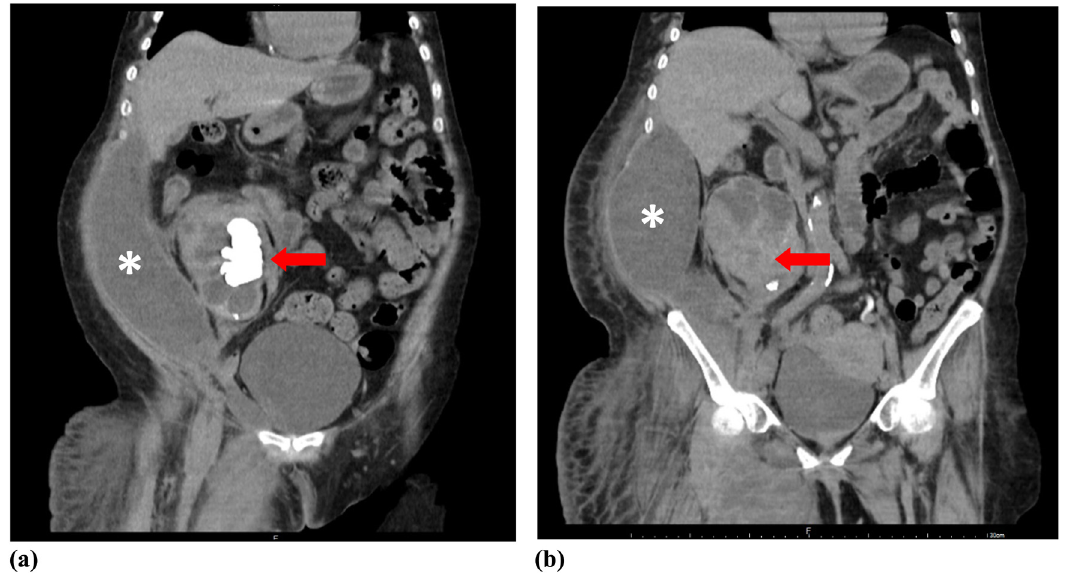
Figure 1: Patient CT. CT imaging revealed. ( a ) A staghorn stone ( red arrow ) occupying the renal pelvis with dilated calyces and hydronephrosis and ( b ) heterogeneously enhanced soft tissue ( red arrow ) with extensive abscesses ( * ) over the right